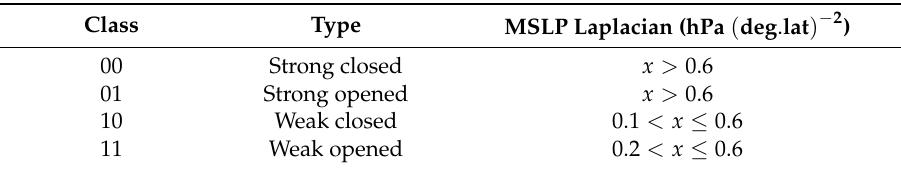
Table 1. System classification based on the Laplacian of the MSLP field